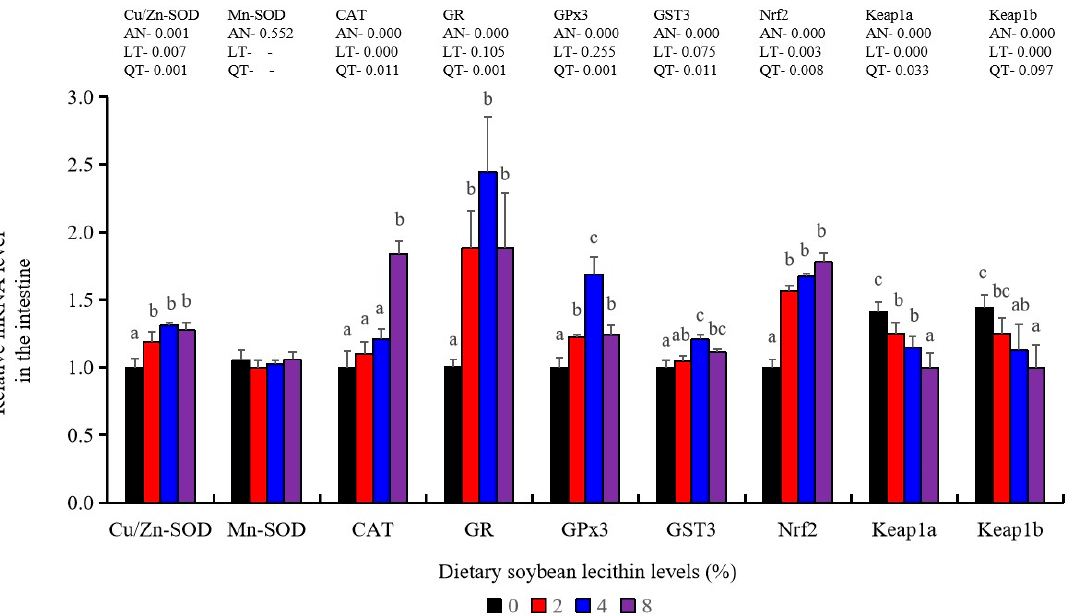
Figure 7. E ff ect of dietary soybean lecithin on expression levels of antioxidant-related genes in the intestine of juvenile largemouth bass. Bars with di ff erent le tt ers indicate signi fi cant di ff erences ( p < 0.05), while that with the same le tt er or no le tt er superscripts indicate no signi fi cant di ff erences ( p > 0.05), AN: ANOVA, LT: linear trend, QT: quadratic trend.